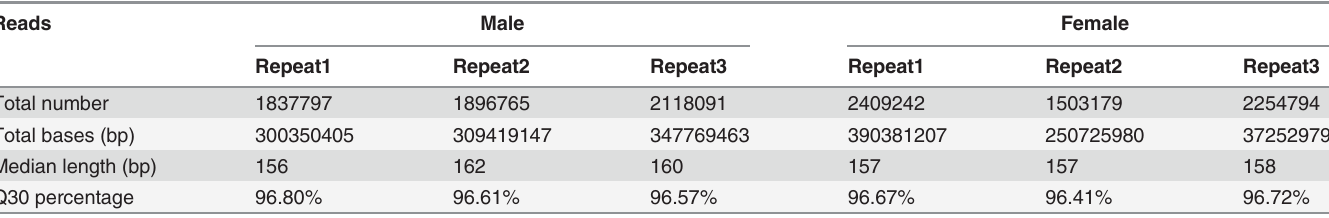
Table 3. Summary of sequencing